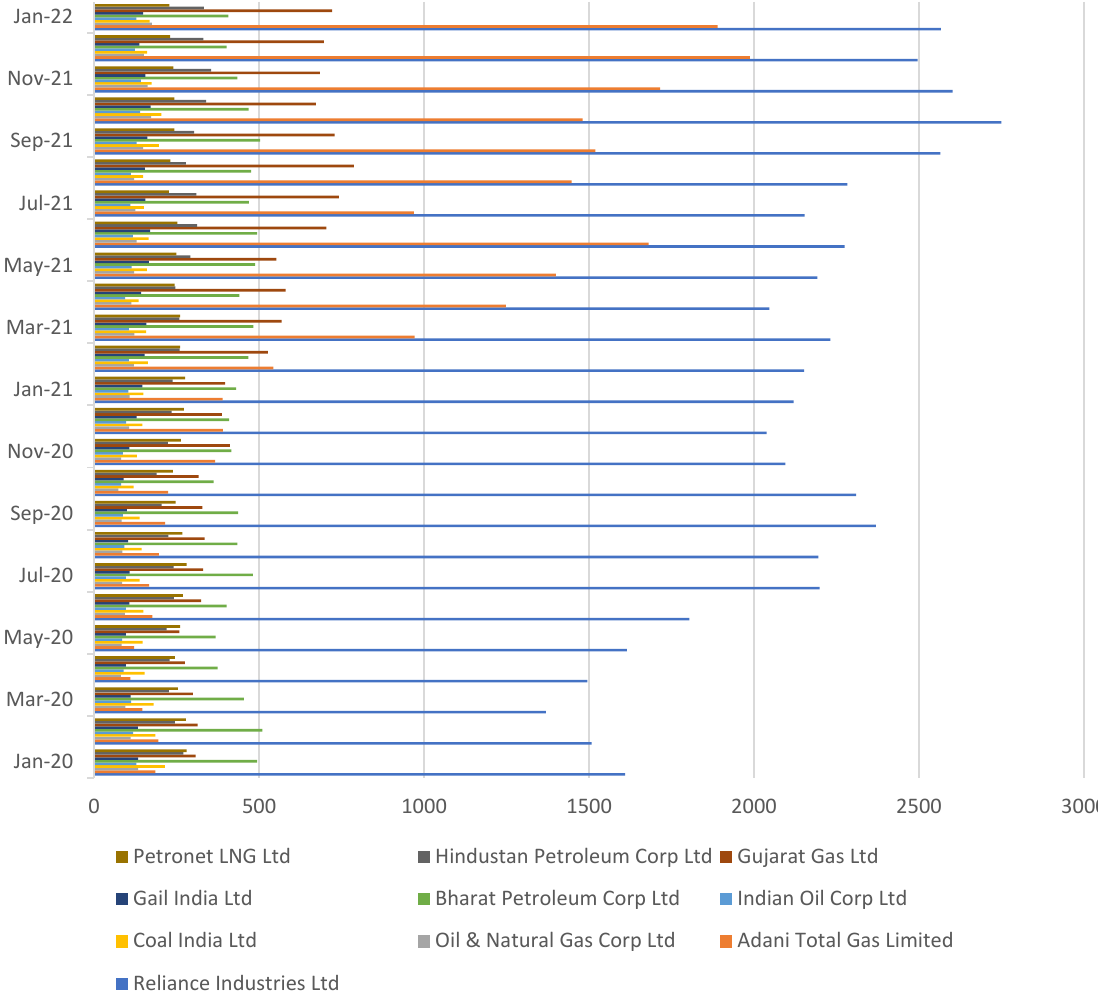
Figure 5. S&P BSE Energy Index Top Ten Companies’ Monthly Performance January 2020–January 2022. Source: https://www.bseindia.com/markets/equity/EQReports/StockPrcHistori.aspx?expand-